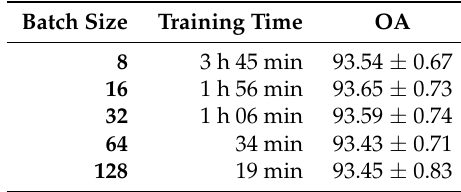
Table 7. Training time and averaged Overall Accuracy (OA) over five folds for the same model learned for five batch